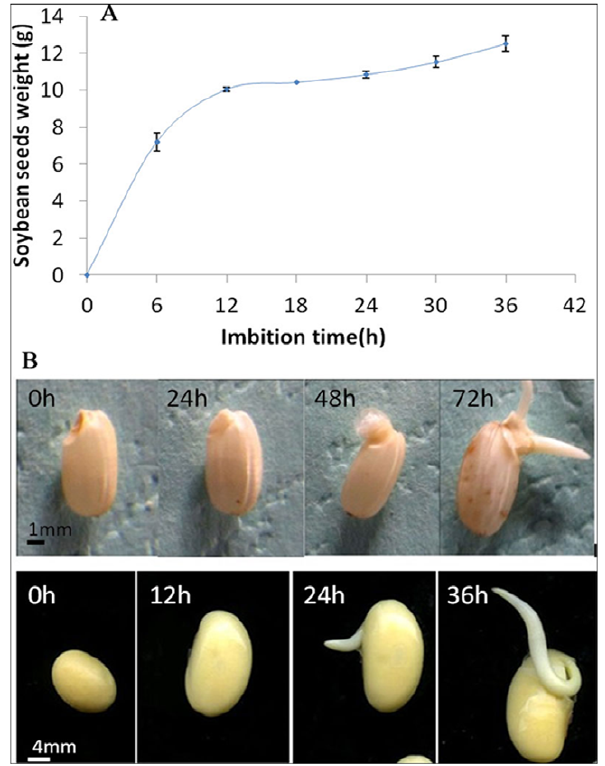
Figure 1. Germination process of soybean and rice seeds. A) water absorption curve during soybean seed germination; B) images of rice and soybean seeds during germination. Bars are 1 mm in rice images and 4 mm in soybean images.